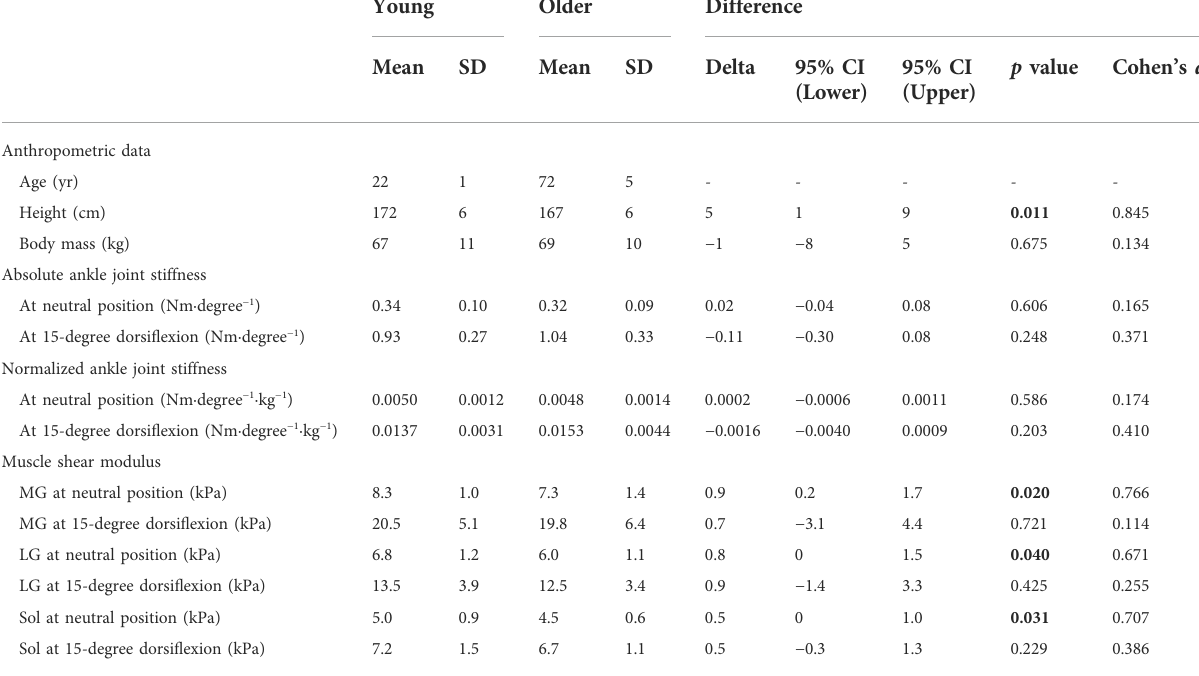
TABLE 1 Anthropometric data, passive ankle joint stiffness, and muscle shear modulus of the